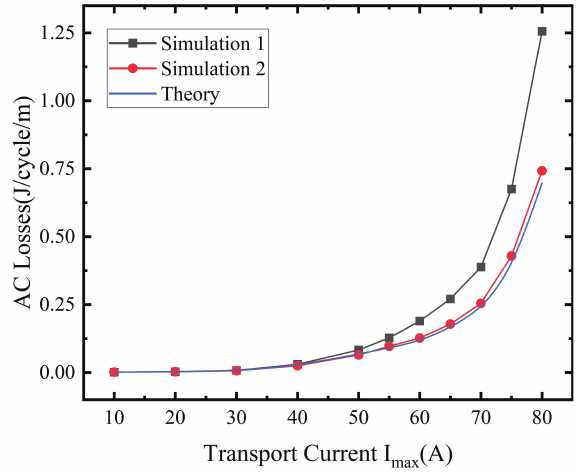
Figure 3. AC loss comparison between the theory and simulation. (Simulation 1: consider field dependences; Simulation 2: no T and H dependences).